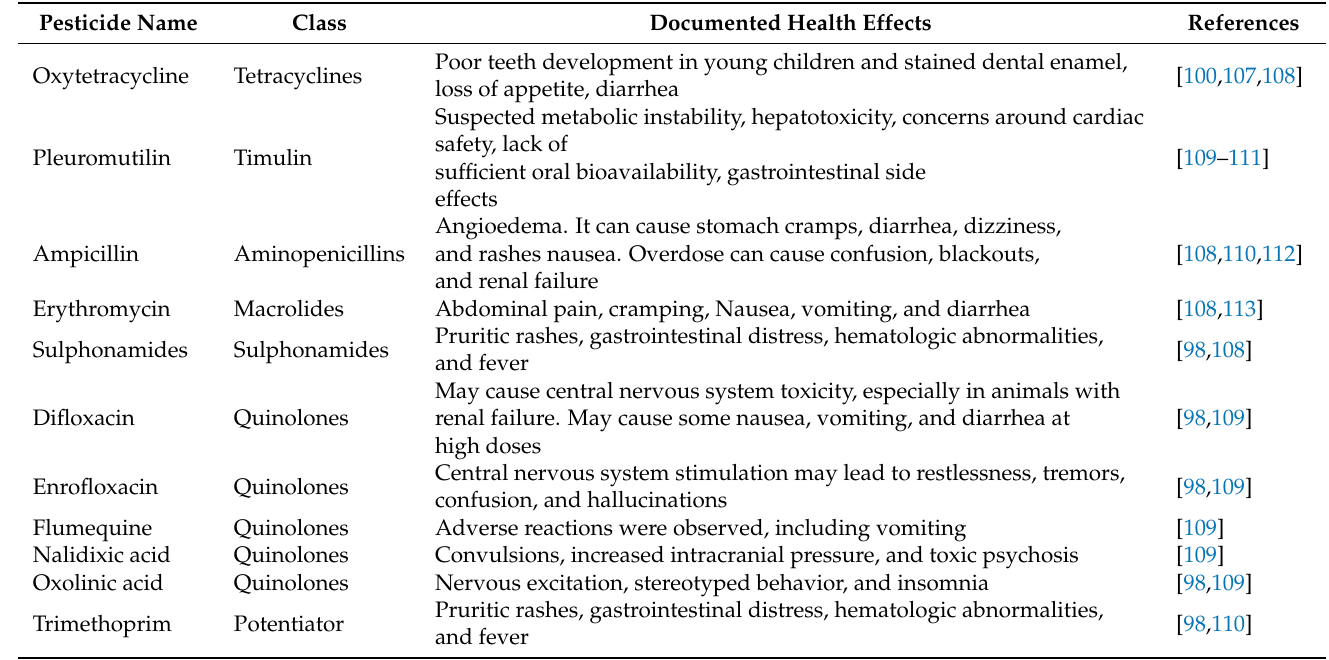
Figure 6. Fate of Veterinary antibiotics [114]. Copyrights Elsevier. Table 4. Summary of the classification of antibiotics and human health